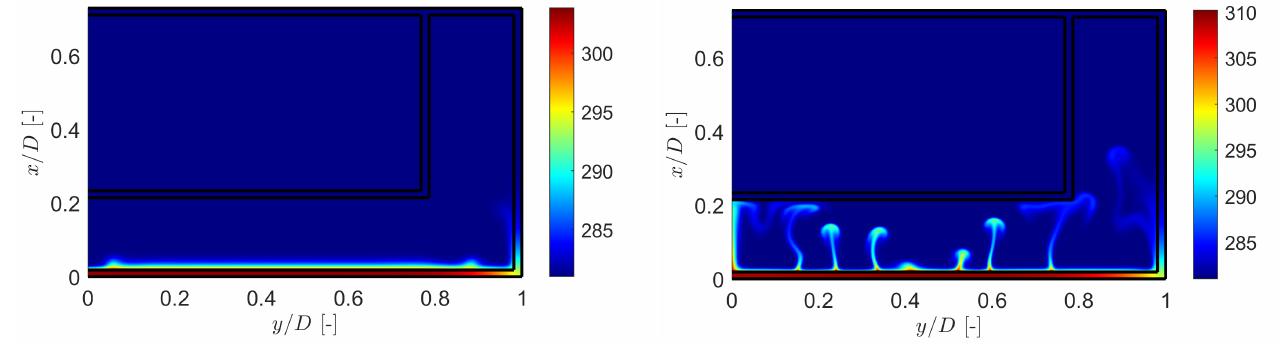
Figure 7. Temperature profile in the cooker in the initial stage of heating. ( Left ) t = 72 s and ( Right ) t = 96 s.